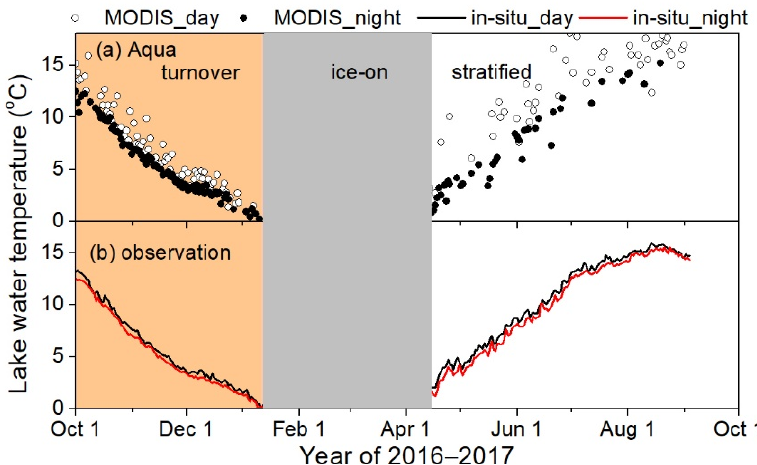
Figure 5. Time series of ( a ) MODIS retrievals and ( b ) in-situ data in the daytime and nighttime for Lake Zhari Namco in the year of 2016–2017.